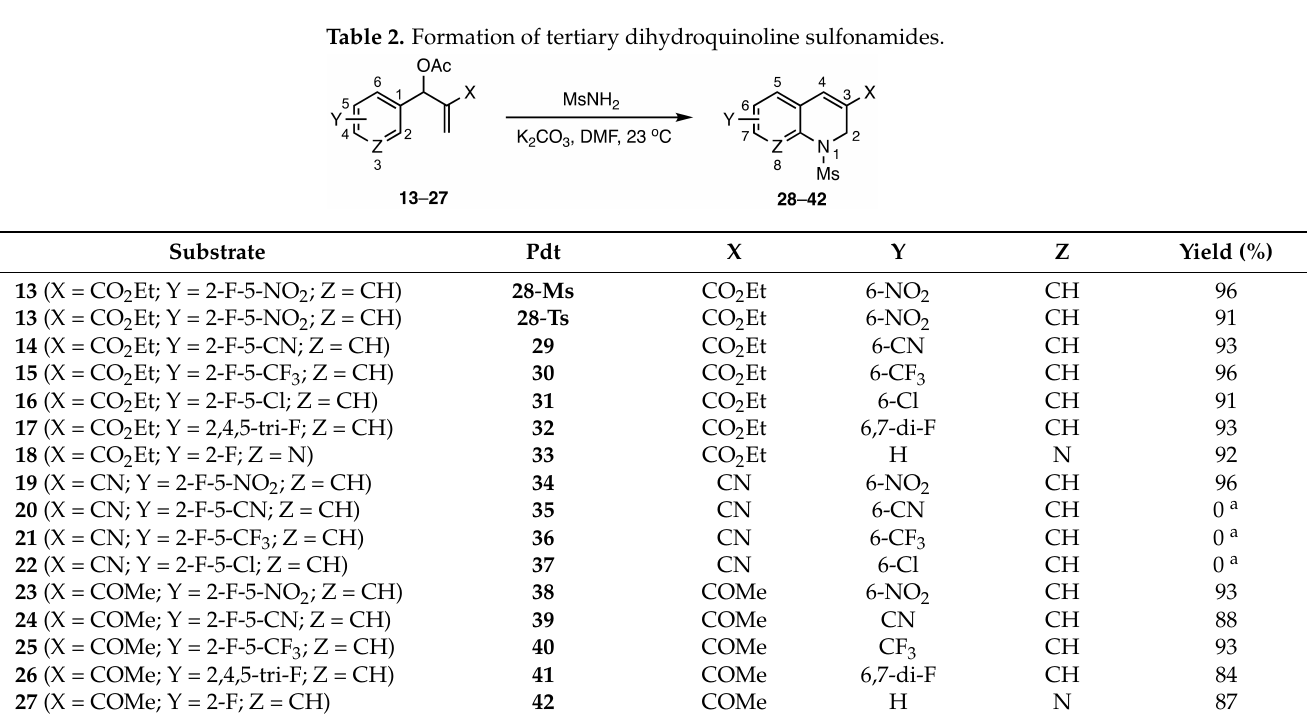
Table 2. Formation of tertiary dihydroquinoline